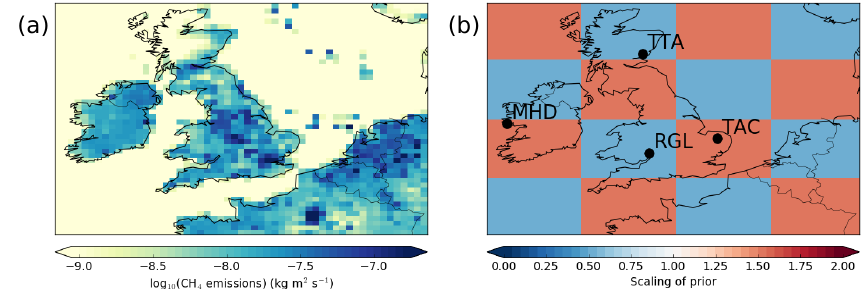
Figure 2. (a) The underlying EDGAR methane emissions mapped onto the NAME output resolution, used as the prior in our inversions. Note the log scale. (b) The chequerboard scaling pattern applied to the EDGAR emissions to create the true emissions field. The location of the DECC sites used are shown by the black dots showing (from north to south): Angus, Scotland (TTA), Mace Head, Ireland (MHD), Tacolneston, England (TAC) and Ridgehill, England (RGL).